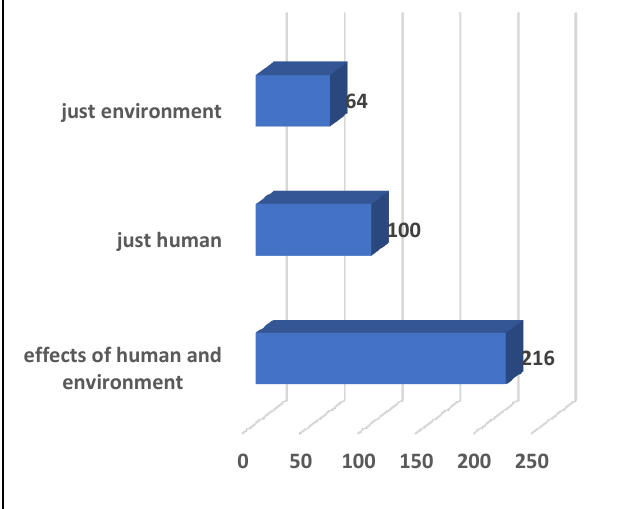
Fig. 8. Purpose of buying shopper